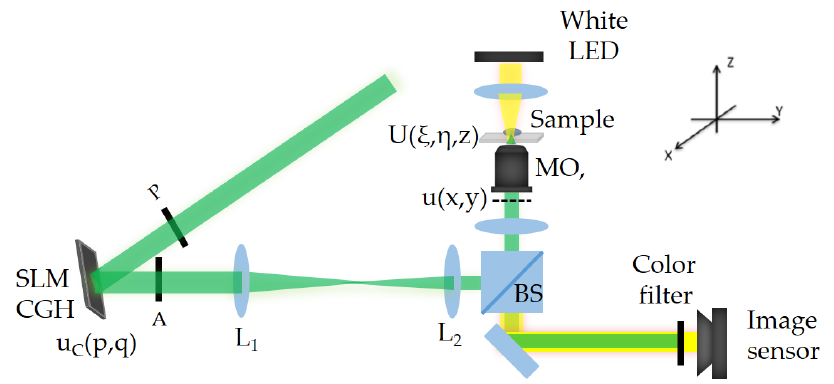
Figure 1. A typical HOT